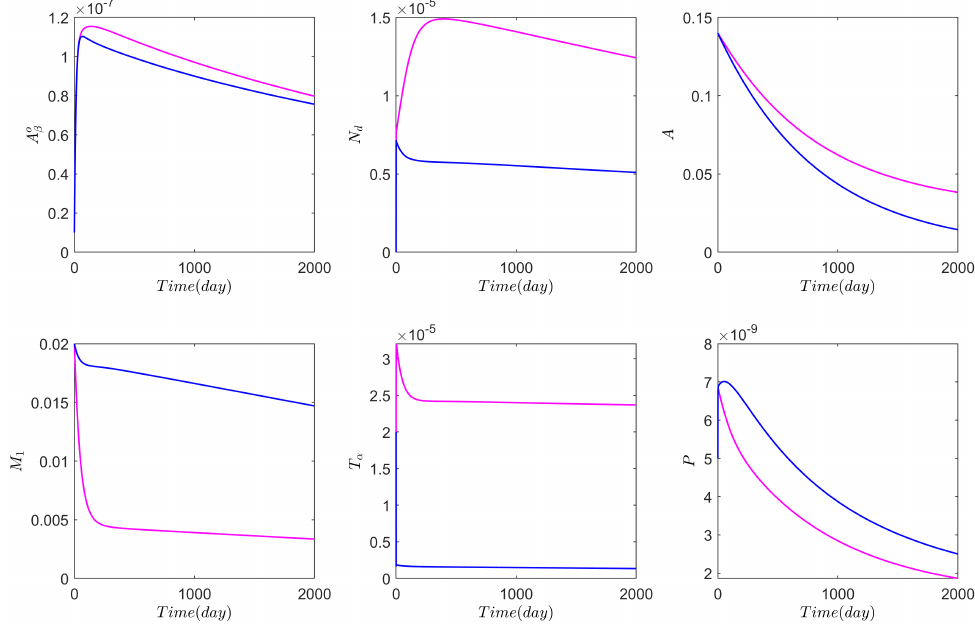
Figure 3. Average solutions of the six variables associated with astrocytes and microglias. We take all the parameter values from Tables 1 and 2 with λ AA o curve curves correspond to the absence and presence of TNF- α inhibitor, respectively.